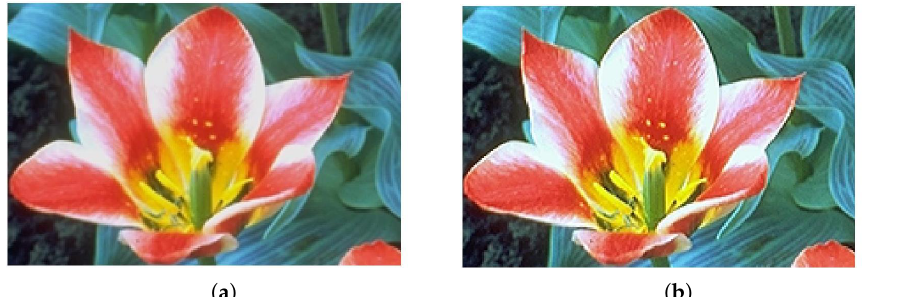
Figure 12. Example 3: Zoom-in of Figure 11a,d, showing a detail of the sharpening results obtained using the proposed stochastic computing CNN. ( a ) Zoom-in of the original image. ( b ) Zoom-in of the sharpened